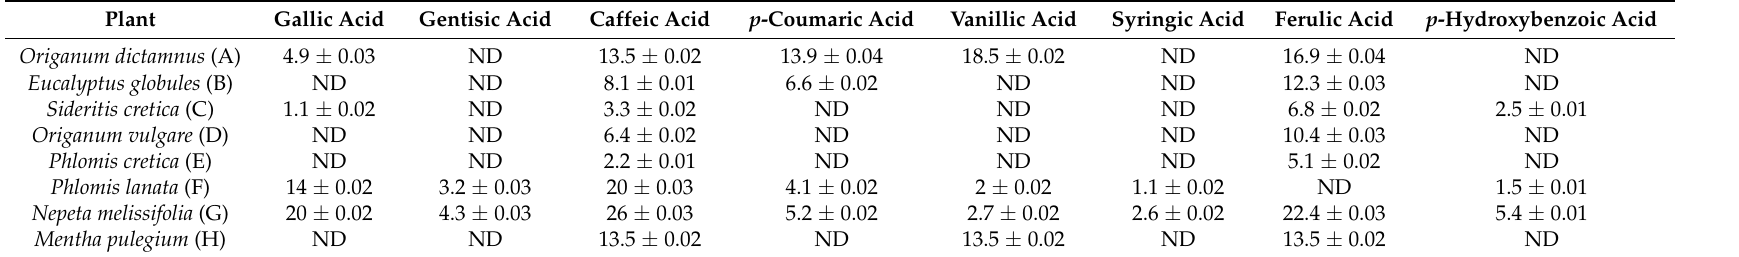
Table 3. Content of phenolic acids in the examined plant extracts (expressed in mg/100 g dry sample a ). Plant